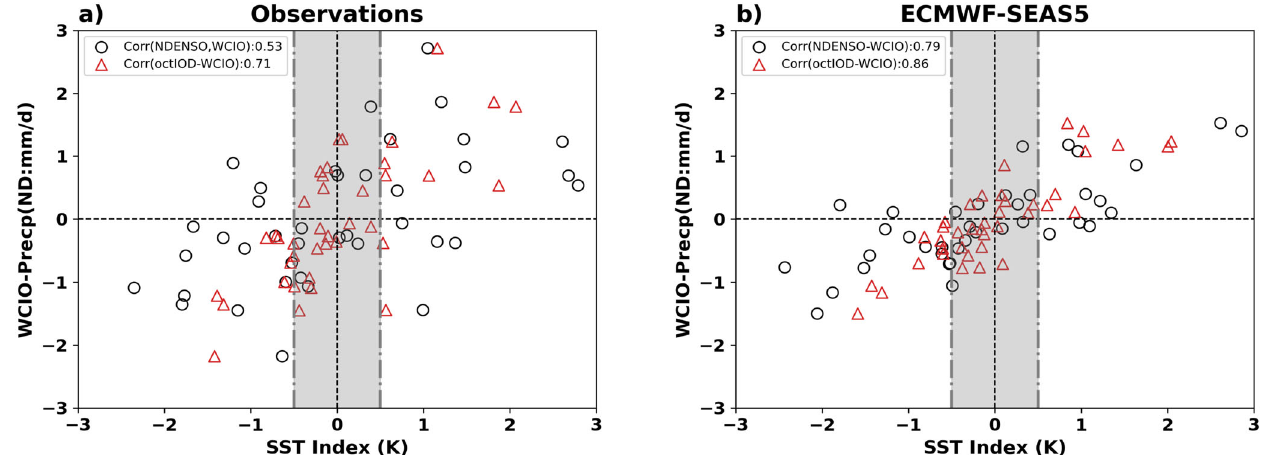
Fig. 2 ENSO vs IOD relationship with WCIO precipitation anomalies. a Observed Scatter plots for the early winter (November – December; ND) WCIO precipitation with the November – December (ND) Niño3.4 (black open circles) and October IOD (red triangles) SST based indices. The grey shaded region corresponds to ±0.5 K SST anomalies. Correlation Coef fi cient (CC) of ND-WCIO precipitation index and ENSO(IOD) SST index is 0.53 (0.71) and slope is 0.43 (0.92) mmd − 1 /K; ( b ) same as of panel ( a ) but for ECMWF-SEAS5, CC between ND-WCIO precipitation and ENSO(IOD) is 0.79 (0.86) while the slope is 0.43 (0.75) mmd − 1